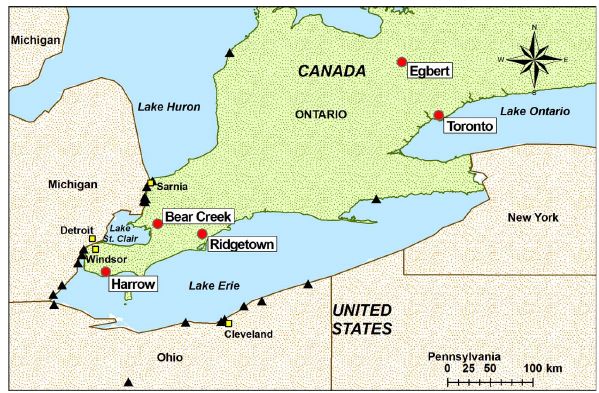
Fig. 1. Locations of the five monitoring sites (dots) and coal-fired power plants